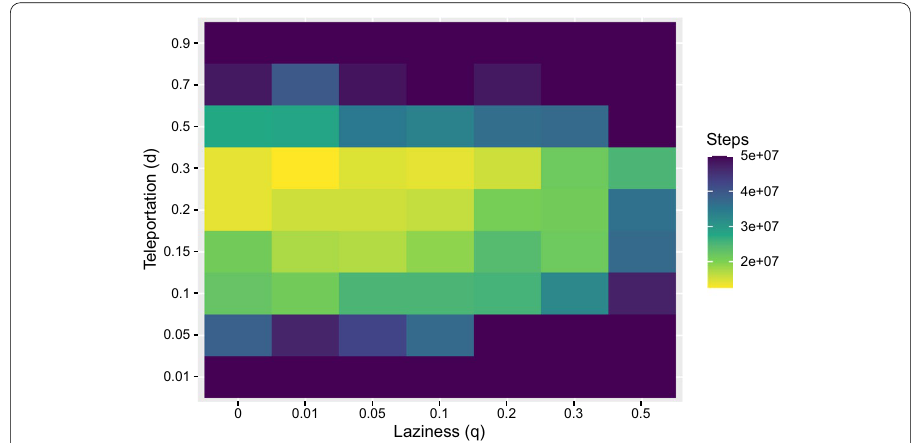
Fig. 1 Number of steps required to have total absolute percentage error between estimated and actual out-TempoRank score below 1%, as a function of laziness ( q ) and teleportation ( d )